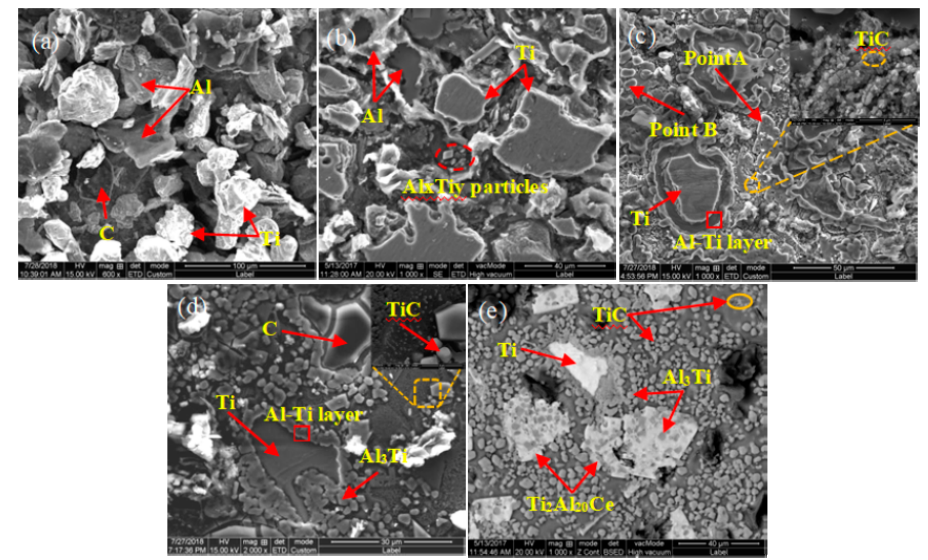
Figure 6. SEM images of 5# pressing block reaction at different time: ( a ) 8 s; ( b ) 50 s; ( c ) 60 s; ( d ) 80 s, and ( e ) 90 s. Table 4. EDS composition analysis of point A and point B in Figure 7c. Point No.